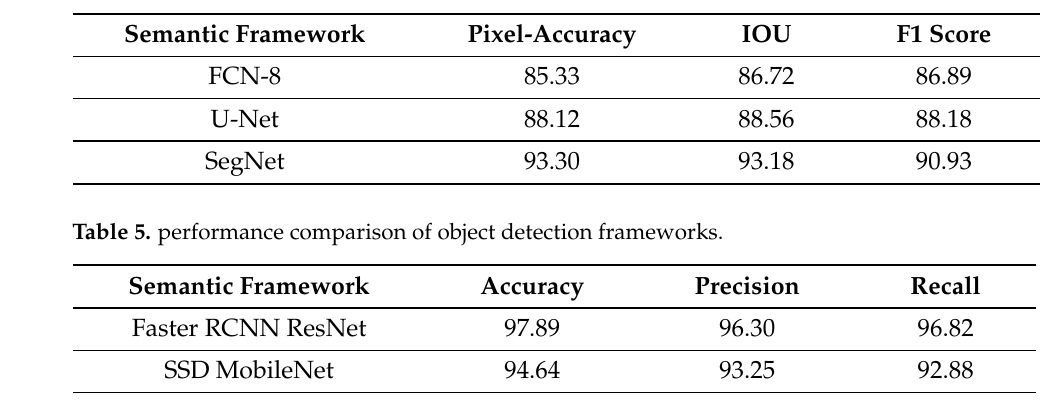
Table 4. performance comparison of segmentation frameworks.